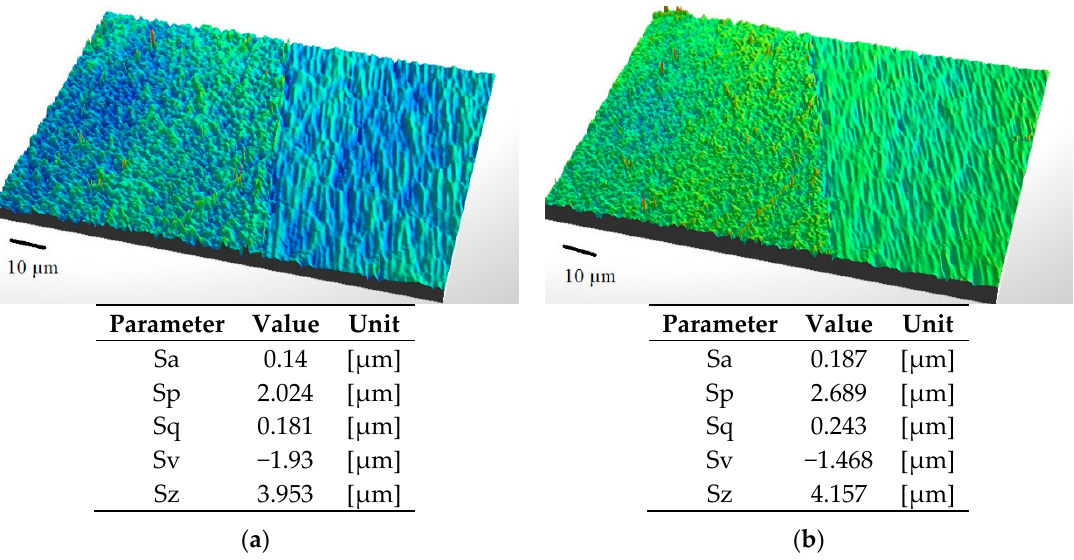
Figure 4. Images of Ti–6Al–4V titanium alloy samples surface with clear limit after ionic polishing: ( a ) Before ozone treatment; ( b ) after ozone treatment (samples after ozone treatment: 50 g O 3 /m 3 for 45 min).